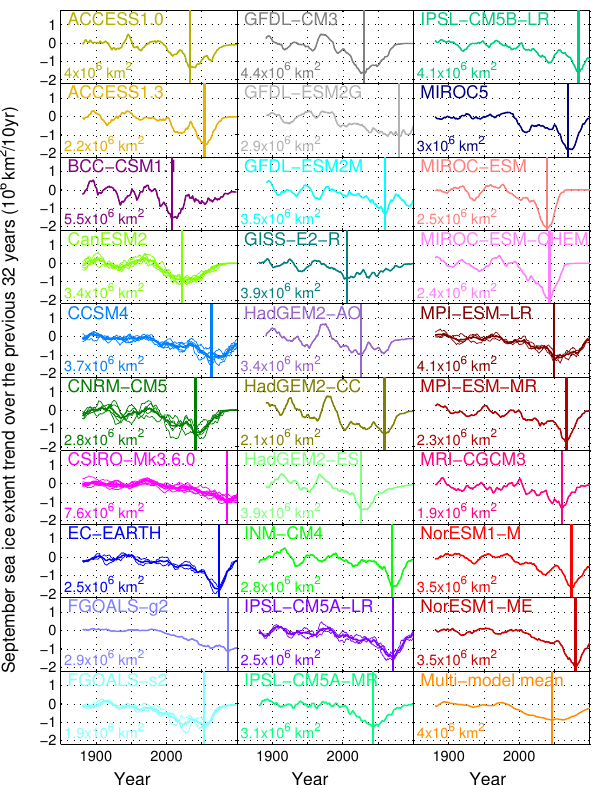
Fig. 3. Running trends (calculated on moving 32-yr windows) in SSIE under historical and RCP8.5 forcings. Members of the same model, if any, are represented by thin lines. Individual models (or the mean of all their members, if any) are represented by thick lines. The vertical line denotes the time at which the trend achieves its minimum, and the number at the lower-left of each panel is the mean SSIE at this